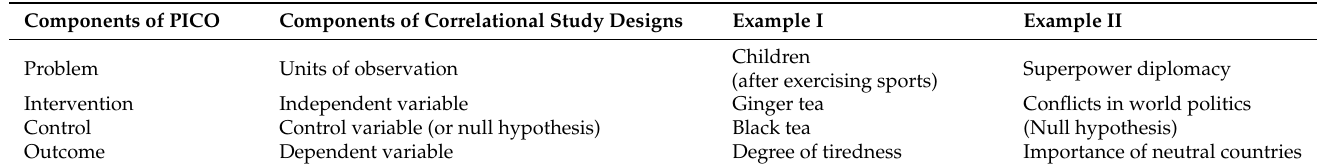
Table 1. The correlational PICO